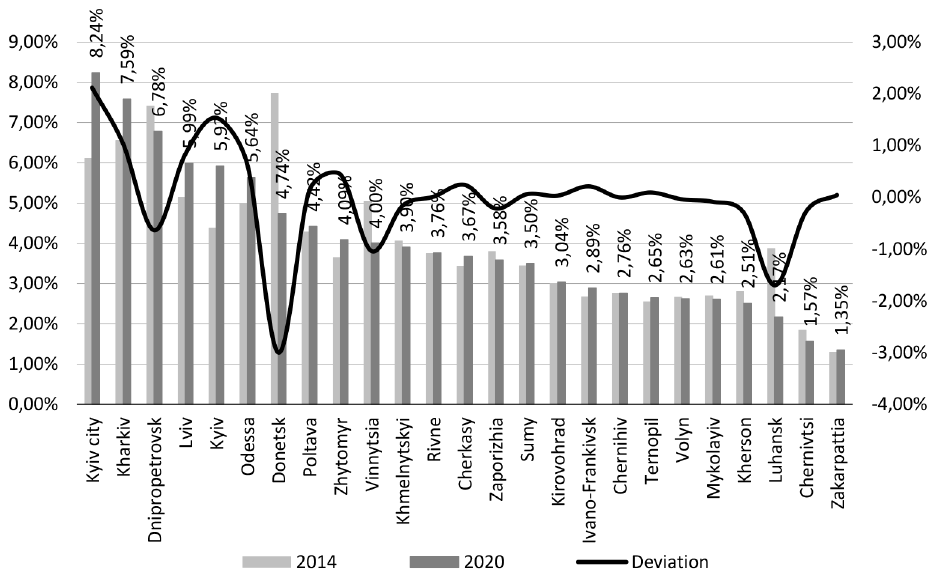
Figure 3. Participation of regions in internal migration in Ukraine by the indicator of departures intensity in 2014 and